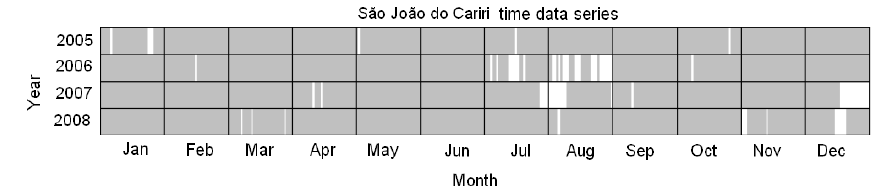
Fig. 1. Available data series for the meteor radar located at Cariri. The blank blocks indicate data gaps.